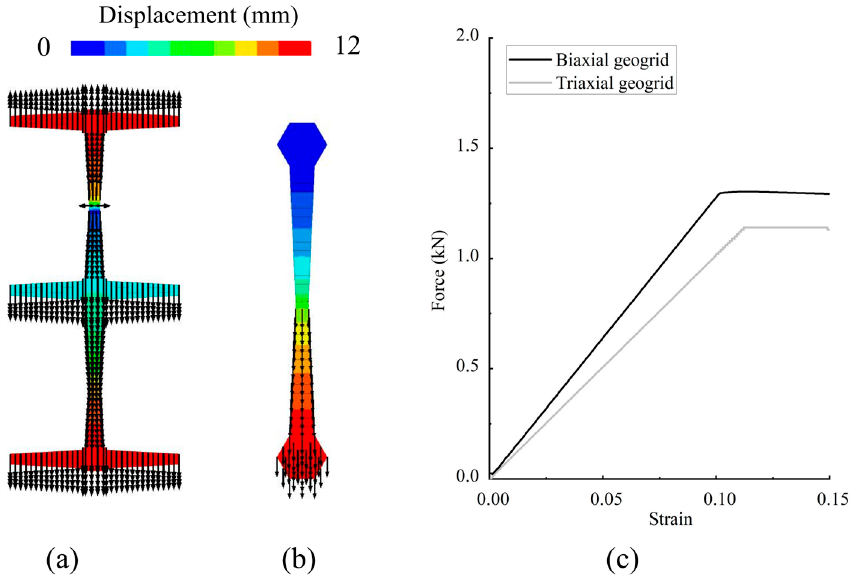
Figure 3. Calibration test simulation and calibration results: ( a ) a single rib test of triaxial geogrid; ( b ) single rib test of biaxial geogrid and ( c ) force-strain curve.